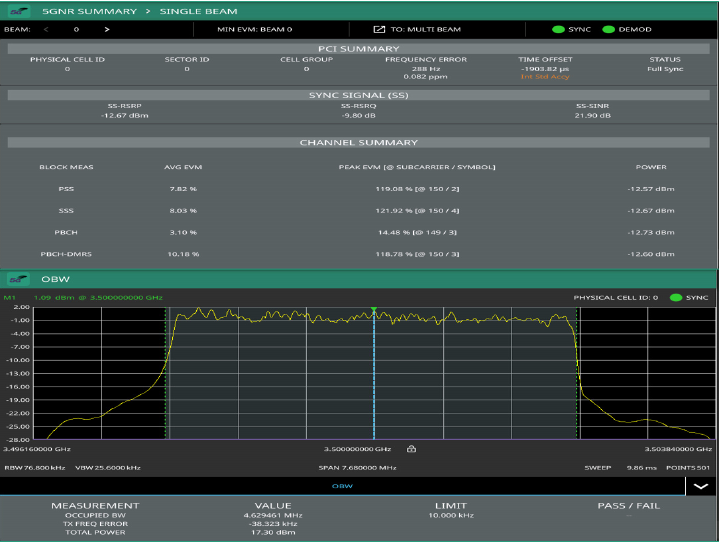
Figure 3. Hardware interface testbench for D&F relay node co-operative 5G network.